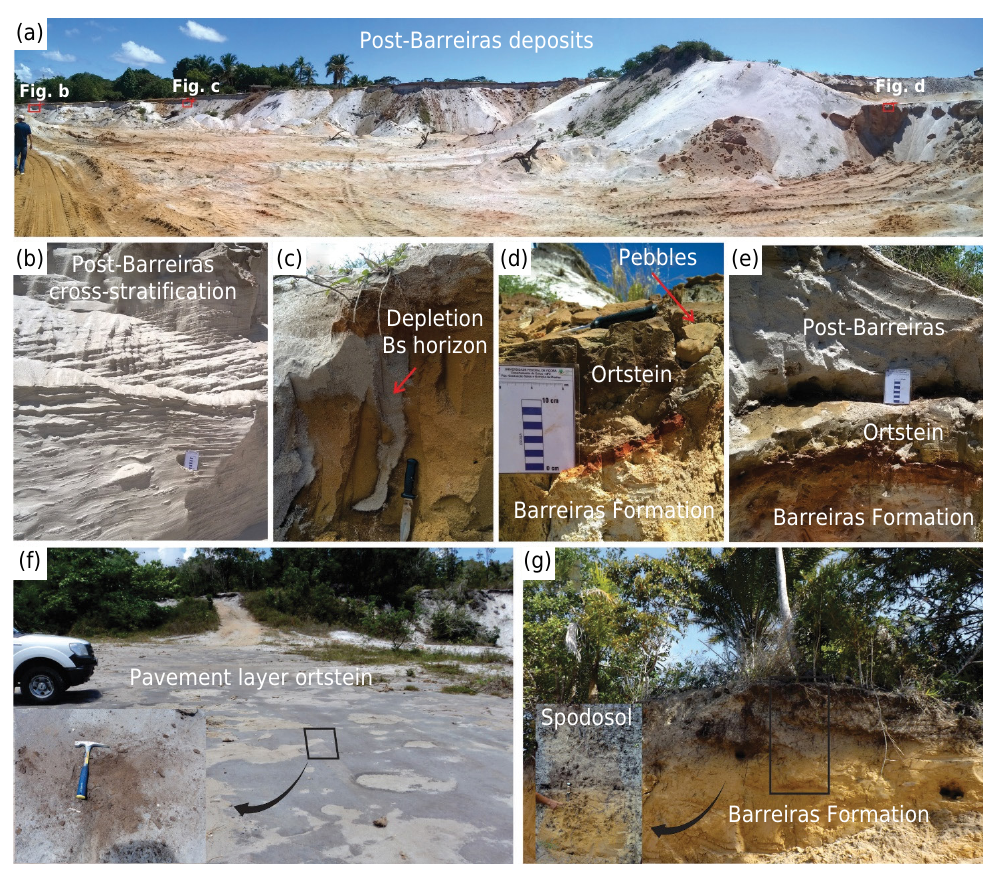
Figure 2. Typical occurrence of Post-Barreiras sediments with demarcated sedimentary and pedological features (red frame) (a); cross-stratification in Post-Barreiras sediments (b); pedological feature of organic matter and iron illuviation in Post-Barreiras sediments, with B-horizon depletion (c); contact area Post-Barreiras and Barreiras Formation, with the presence of cemented organic horizon and pebbles (d and e); residual ortstein layer after sand extraction by mining activity (f); and sandy layer resulting from pedogenesis in sediments from the Barreiras Formation, with emphasis on the Spodosol profile in these environments (g).